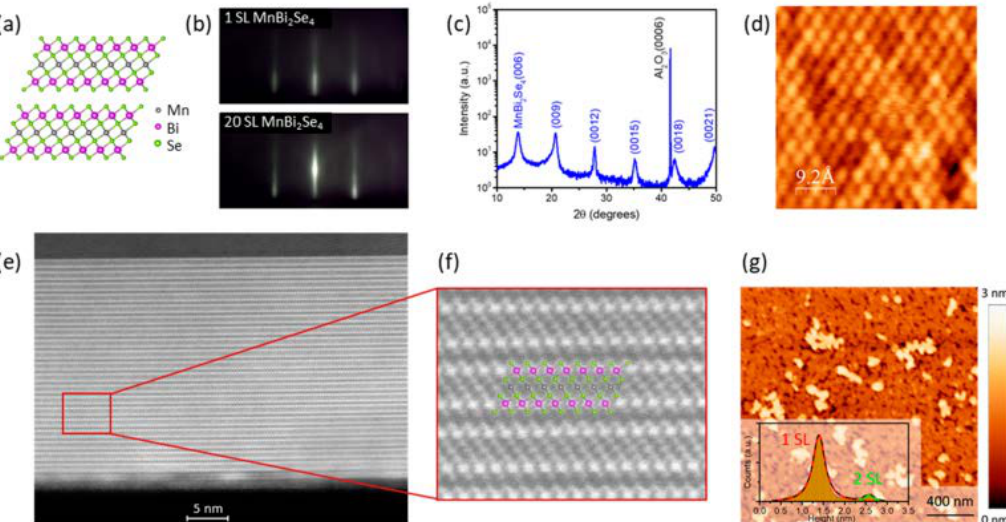
Figure 8. Characterization of structural characteristics of MnBi 2 Se 4 on Al 2 O 3 . ( a ) The atomic crystal morphology more than one-layer MnBi 2 Se 4 contains van der Waals stacked septuple layers (SLs) of Se, Bi, Mn, and Bi. ( b ) On MnBi 2 Se 4 films, streaky RHEED patterns at 1 SLs and 20 SLs thicknesses reveal the 2D surface structure. ( c ) XRD scans of a 20 SLs MnBi 2 Se 4 clear indicates for Al 2 O 3 and the MnBi 2 Se 4 planes are visible. ( d ) A STM are used to determine the Atomic-scale surface structure of a 20 SLs MnBi 2 Se 4 film with a 4.0 ± 0.1 ˚A — in plane lattice constant. by ( e ) cross-sectional STEM imaging of van der Waals stacking ( f ) Enlarged STEM image of MnBi 2 Se 4 . ( g ) atomic force microscope image of 1 SL film. (Copyright © 2021, American Chemical Society) [84].